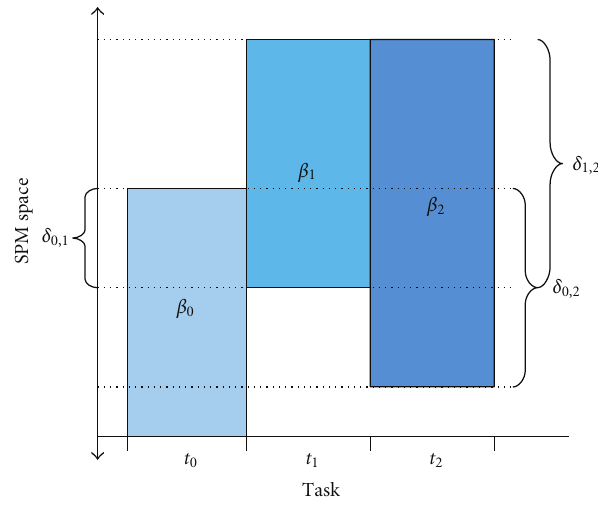
Figure 12: Intersection of